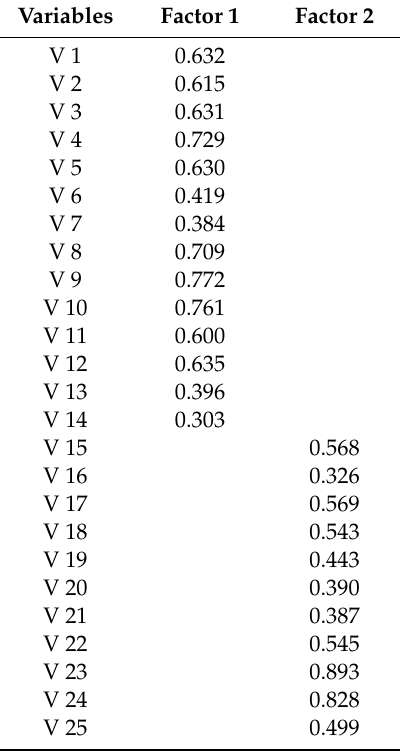
Table 3. Matrix of rotated